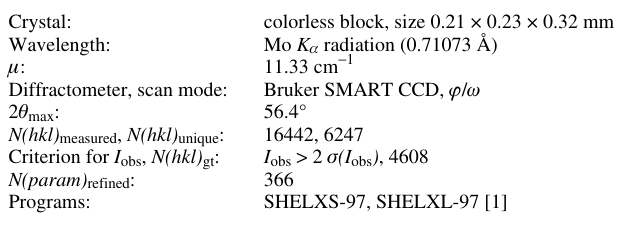
Table 1. Data collection and